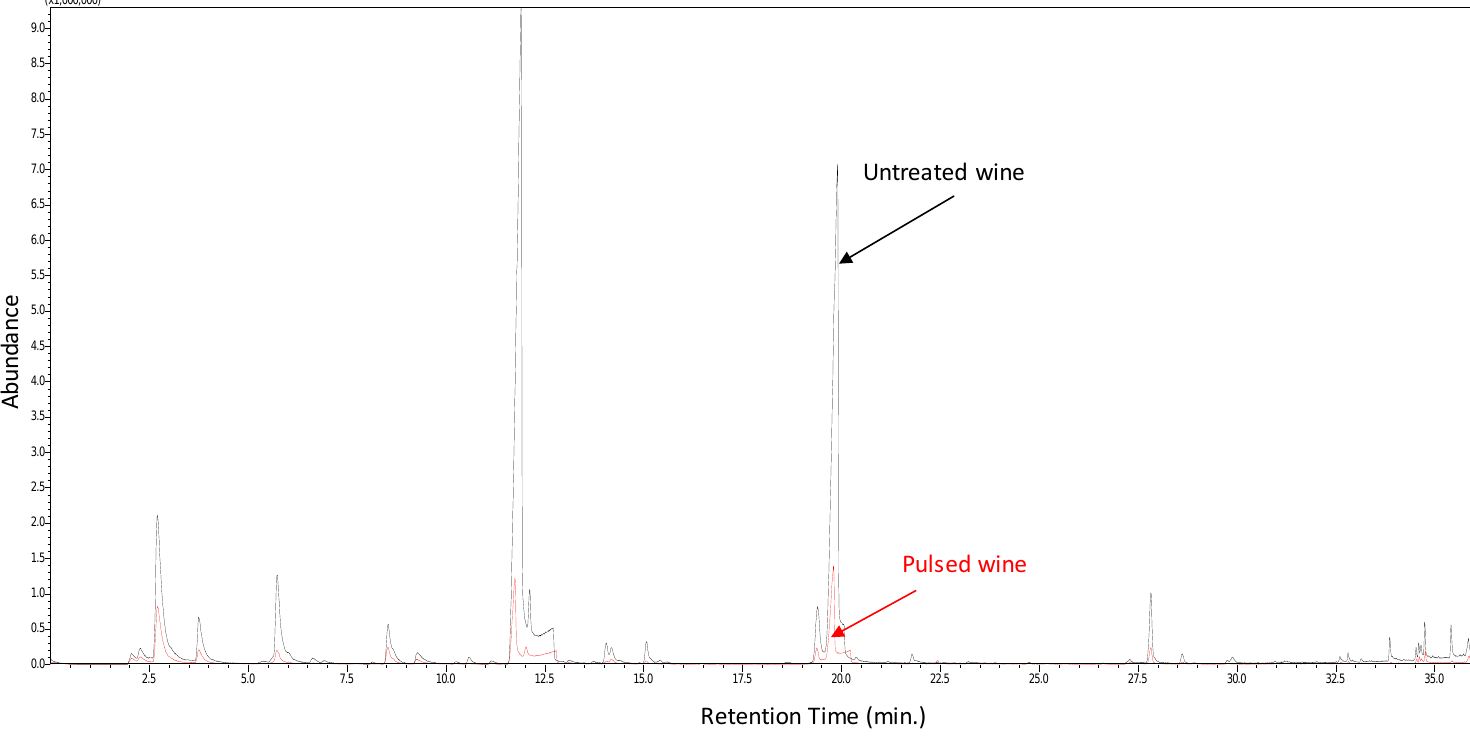
Figure 3. GC-MS chromatograms of untreated and pulsed light treated white wine.